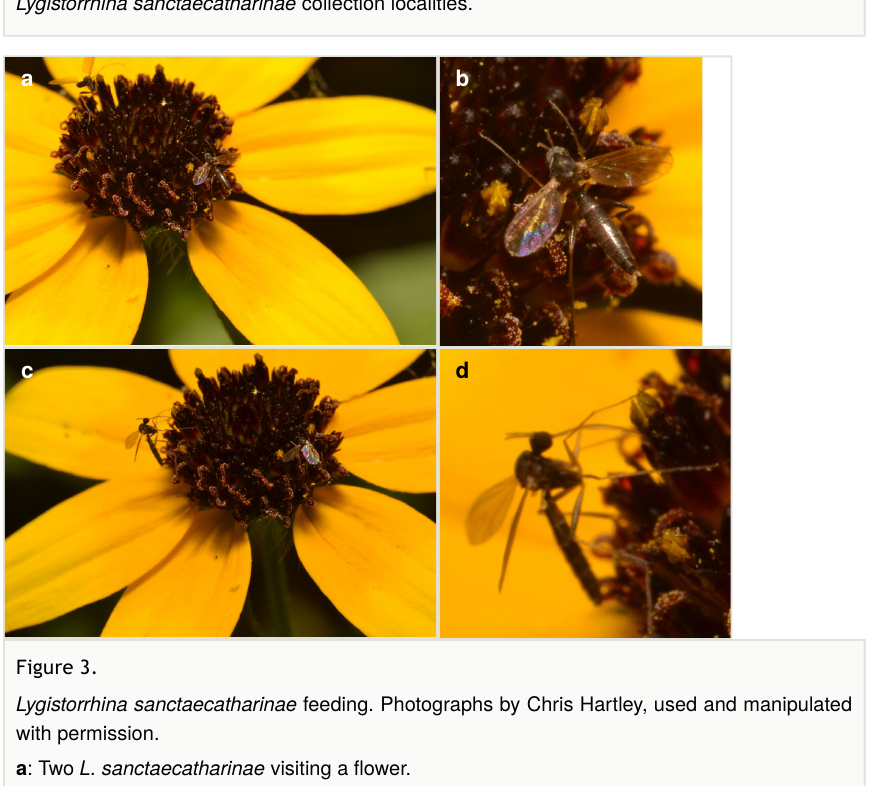
Figure 3. Lygistorrhina sanctaecatharinae feeding. Photographs by Chris Hartley, used and manipulated with